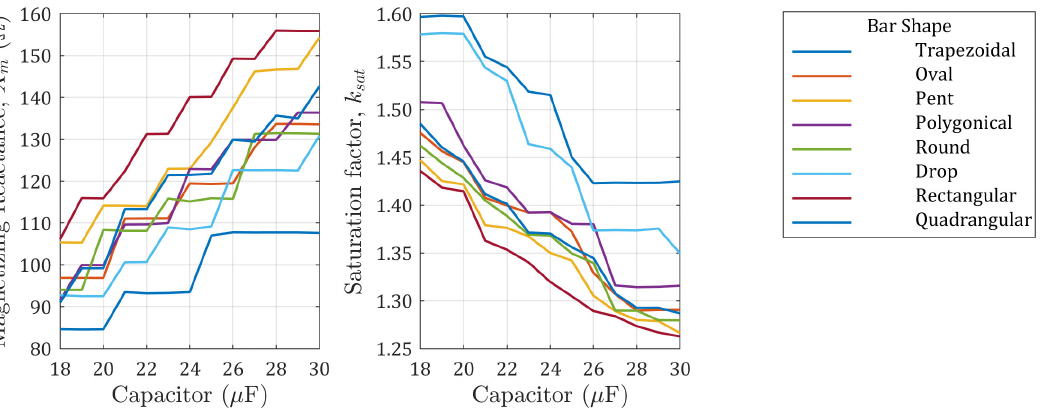
Figure 8. Variation of the SPIM’s magnetizing reactance ( left ) and magnetic saturation factor ( right ) as a function of the run-capacitor value for all the examined rotor bar